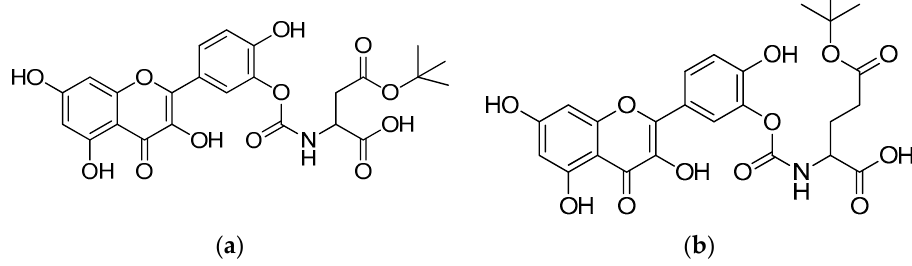
Figure 8. ( a ) Quercetin–aspartic acid conjugate; ( b ) quercetin–glutamic acid conjugate.